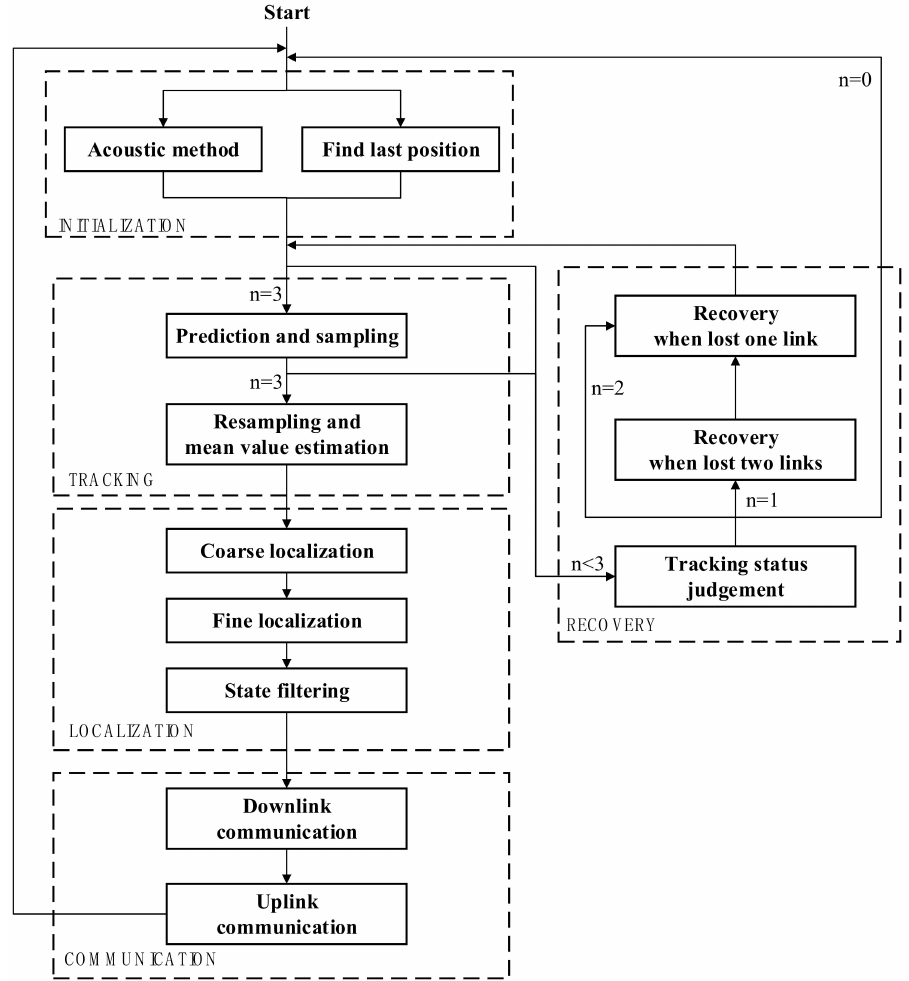
Figure 5. Workflow of the proposed